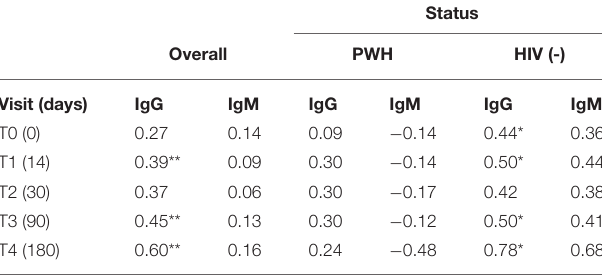
TABLE 3 | Correlation matrix for age, IgG, and IgM at each time point. Status Table 2 . The IgM and IgG Ab responses specific to RBD